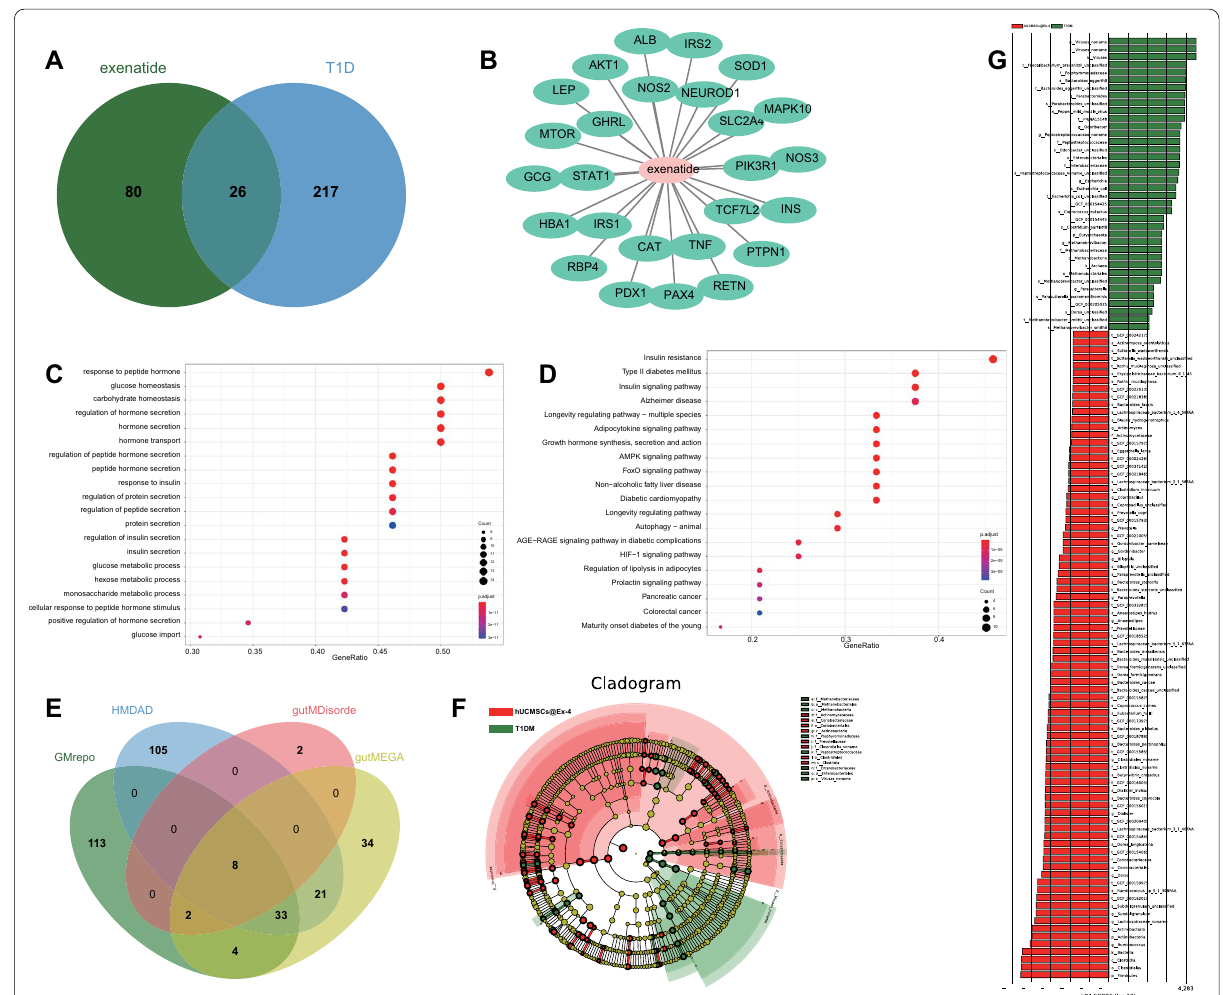
Fig. 4 Bioinformatics analysis to screen the signaling pathways related to hUCMSCs@Ex-4 in the treatment of T1DM and changes in intestinal microflora. A Venn diagram of the exenatide-related genes and T1DM target genes determined using GeneCards. B The drug-target regulatory network. C GO enrichment analysis of 26 target genes. D, KEGG enrichment analysis of the 26 target genes. E Venn diagram of T1DM-related intestinal microflora predicted by the GMrepo, HMDAD, gutMEGA, and gutMDisorder databases. F Fecal intestinal microflora specie cladogram of T1DM mice treated with hUCMSCs@Ex-4 (red) and T1DM mice (green). G Differential fecal intestinal microflora species between T1DM mice treated with hUCMSCs@Ex-4 (red) and T1DM mice